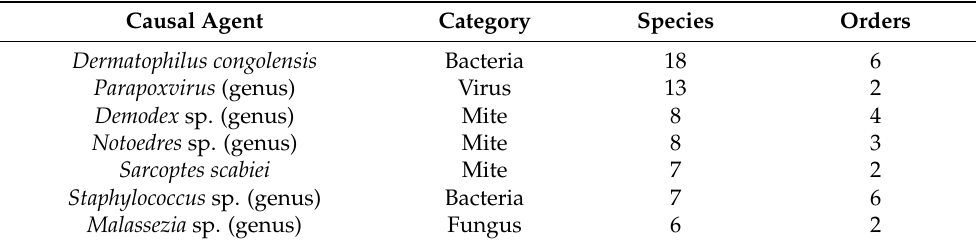
Table 3. The top seven causal agents of dermatitis in wildlife species, with all other causes effecting four or less species (Table S4). For each causal agent, the etiological category, the number of species the agent was reported to cause dermatitis in, and the number of orders is shown.